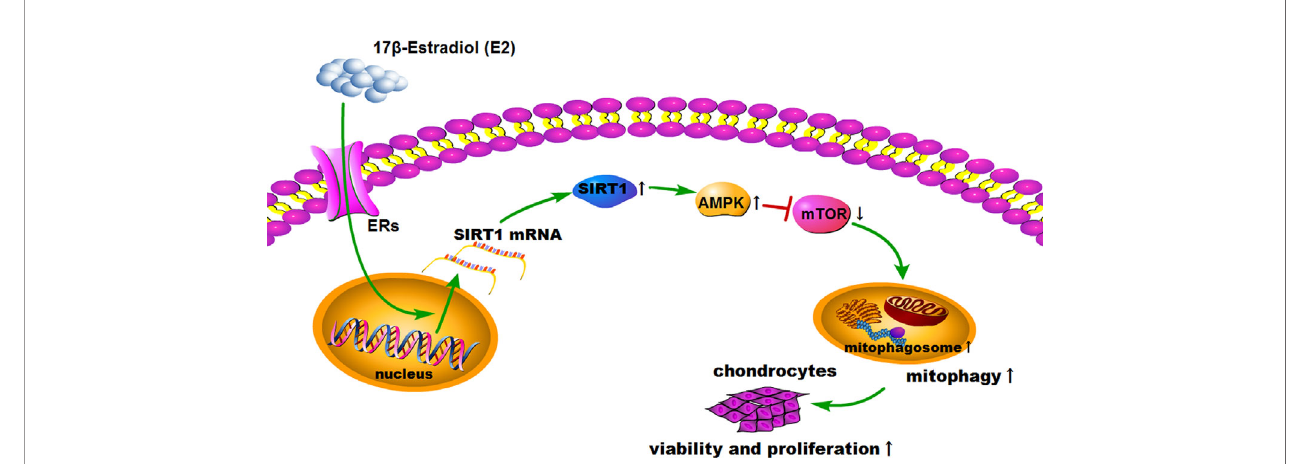
FIGURE 7 | Schematic diagram depicts the proposed and underlying mechanism that 17 b -E2 induces mitophagy up-regulation to protect chondrocytes via the SIRT1-mediated AMPK/mTOR signaling